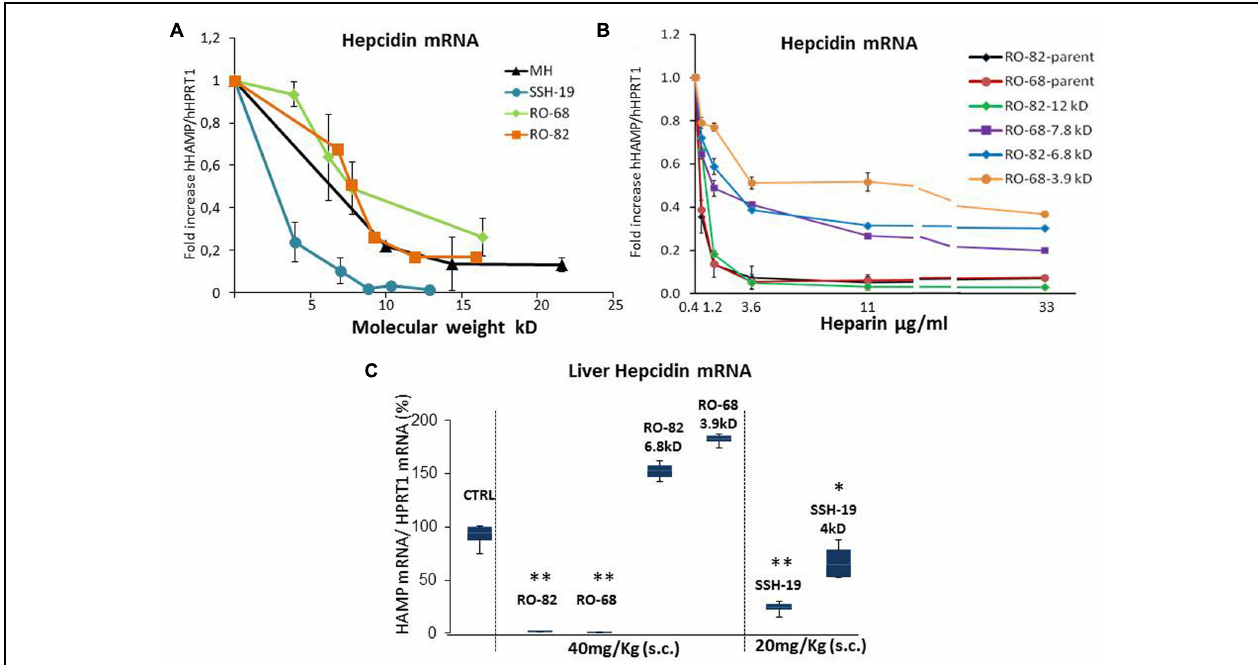
FIGURE 1 | Analysis of different heparin type fractions with different molecular weight. (A) The fractions of the four different heparins, listed in Table 1 were added to HepG2 cells at the concentration of 3.6 µ g/ml for 6 h in presence of 10 ng/mL BMP6 and then the level of hepcidin mRNAs evaluated by qRT-PCR. The residual levels of hepcidin mRNA are plotted vs. the molecular weight of the fractions. (B) Dose-response curves of the two unfractionated RO heparins (RO-82 and RO-68), of their lightest fractions of 6.8 and 3.9 kD and of their highest fractions of 12 and 7.8 kD. HepG2 cells were treated with 0.4-1.2-3.6-11-33 µ g/ml of different heparins for 6 h, in the presence of 10 ng/ml BMP6. The values were normalized for Hprt1 and the means were reported as fold increase of BMP6 stimulated cells, considered as control (value 1 in A,B ). Three independent experiments for (A,B) graphs were performed and the induction of hepcidin expression in presence of BMP6 was reported as fold increase vs. untreated but stimulated cells. (C) The indicated compounds were injected subcutaneously in the mice at the concentrations of 40 mg/Kg for RO-82, RO-68; RO-82 6.8 kD, RO-68 3.9 kD and of 20 mg/ml for SSH-19 (SSLMWH-19) and SSH-19 4 kD. The mice were sacrificed after 6 h and the liver hepcidin mRNA quantified by qRT-PCR. The values were normalized for Hprt1 and reported in a box plot as a percentage of saline treated mice (CTRL). ∗ and ∗∗ is a P -value < 0.005 or 0.001